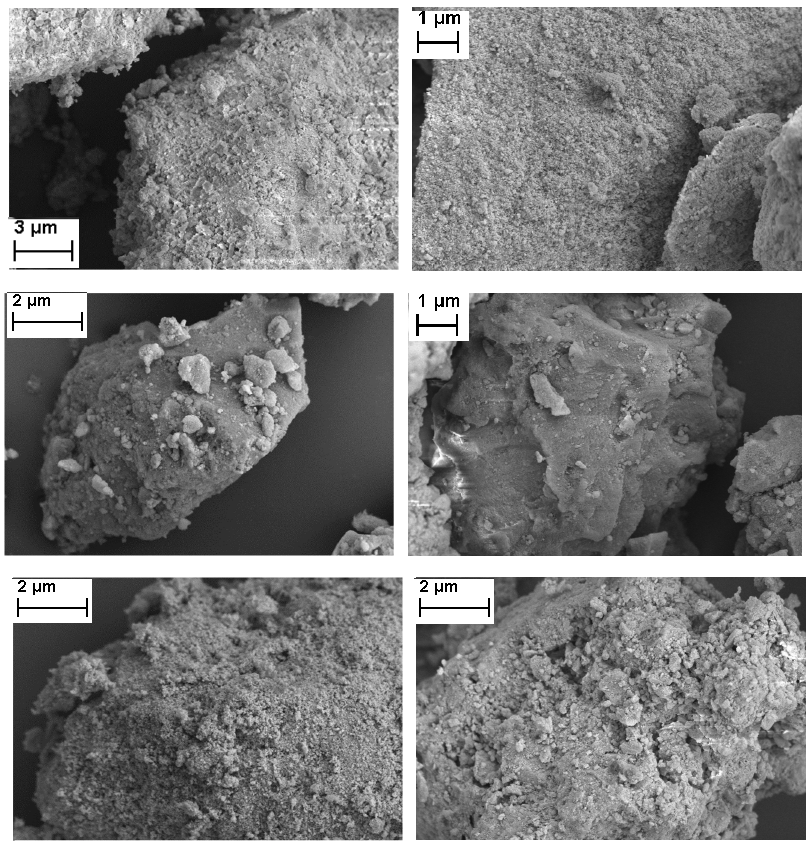
Figure 3. SEM images of the supported cobalt ( left ) and iron ( right ) oxide catalysts. Top: Alumina-